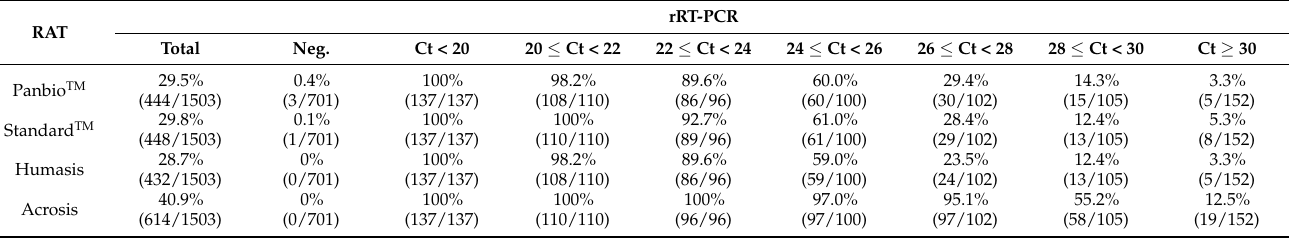
Table 2. RAT results stratified using a detailed classification based on the Ct value.